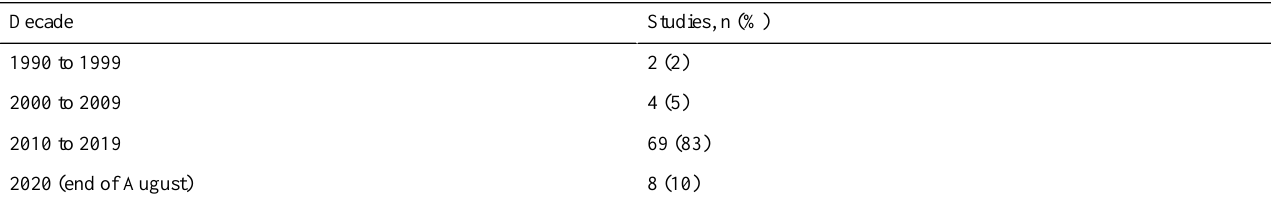
Table 2. Publications on TBIs for depression per decade (N=83).